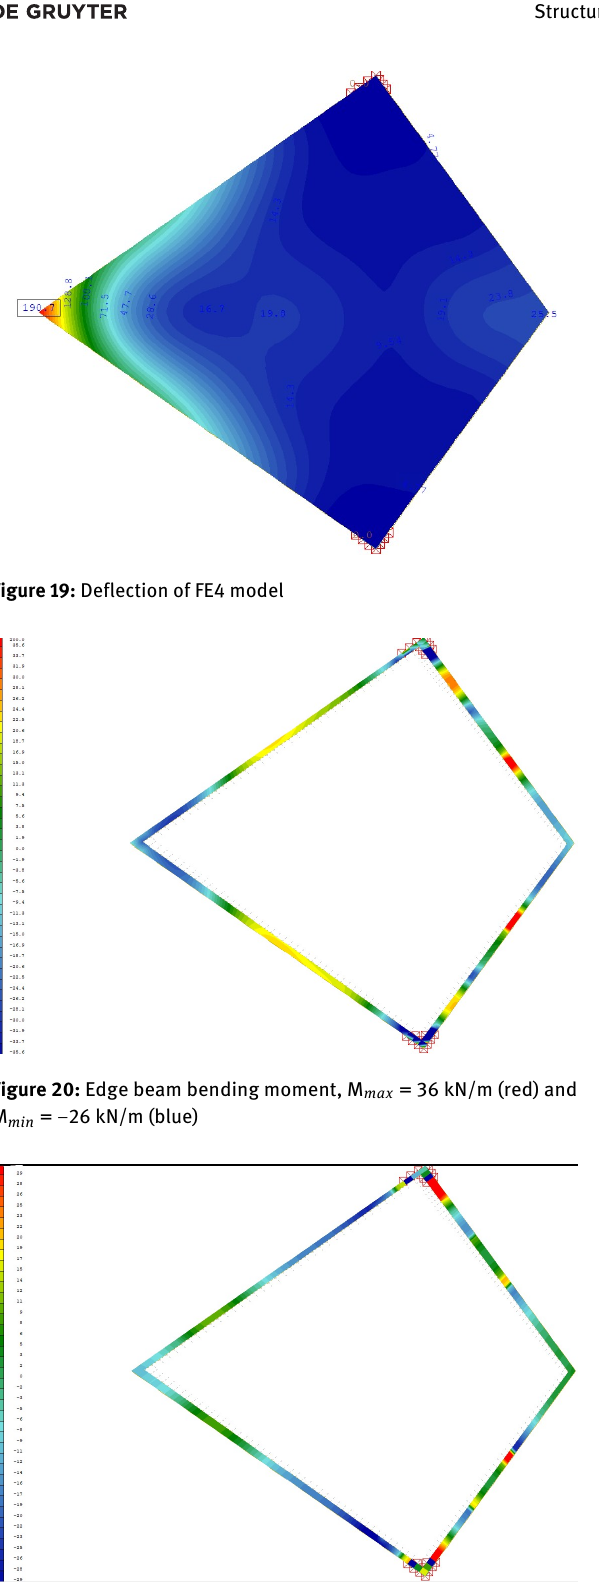
Figure 21: Edge beam bending shear force, V max = 30 kN (red) and V min = − 30 kN (blue)